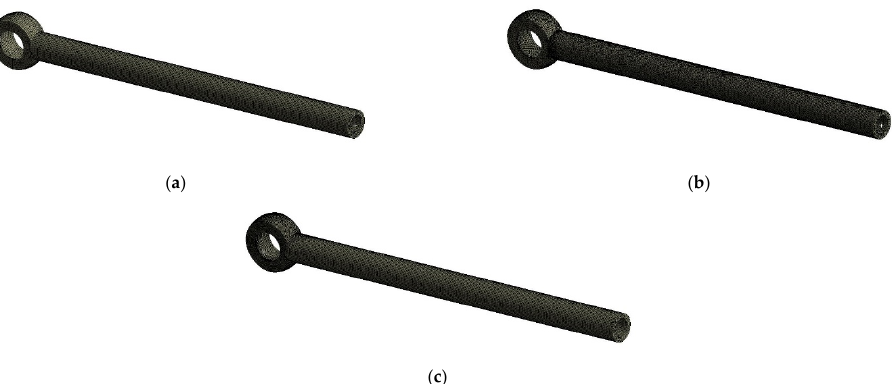
Figure 14. Three grid generation methods for parts: ( a ) hexahedral mesh generation method; ( b ) tetrahedron mesh generation methods with different sizes; ( c ) tetrahedron and hexahedron mesh generation method.